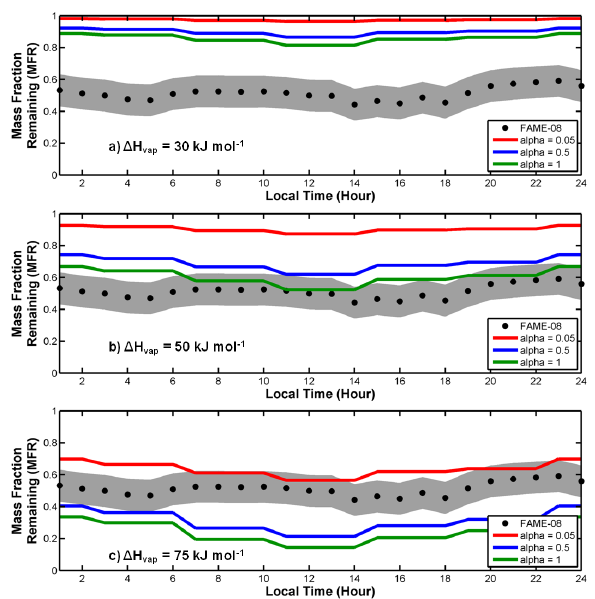
Fig. 5. Comparison of model predicted OA behavior in a ther- Figure 5. Comparison of model predicted OA behavior in a thermodenuder to observations made 964 during FAME-08. Black circles and gray area indicate measurement values and uncertainty, 965 modenuder to observations made during FAME-08. Black circles respectively. The transport model predictions for this base case assumes ΔH vap = 30 kJ mol -1 for 966 and gray area indicate measurement values and uncertainty, respec- aSOA and bSOA species, regardless of volatility, while ΔH vap for POA, iSOA, and sSOA species 967 varies linearly from 130 to 64 kJ mol -1 as effective saturation concentration increases from C * = 968 tively. The transport model predictions for this base case assumes 10 -5 to 10 6 µg m -3 . The dynamic mass transfer thermodenuder model (Riipinen et al., 2010) 969 1H vap = 30kJmol − 1 for aSOA and bSOA species, regardless of assumes all OA mass has ΔH vap = 30 kJ mol -1 (a), 50 kJ mol -1 (b), or 75 kJ mol -1 (c). 970 volatility, while 1H vap for POA, iSOA, and sSOA species varies linearly from 130 to 64kJmol − 1 as effective saturation concen- tration increases from C ∗ = 10 − 5 to 10 6 µgm − 3 . The dynamic mass transfer thermodenuder model (Riipinen et al., 2010) assumes all OA mass has 1H vap =30kJmol − 1 (a) , 50kJmol − 1 (b) , or 75kJmol − 1 (c) .